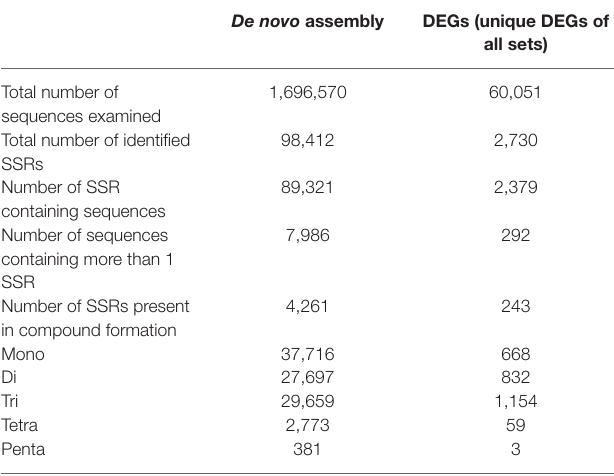
TABLE 3 | Details of SSR markers obtained from de novo transcriptome assembly as well as unique differential expressed genes of all the stages. De novo assembly DEGs (unique DEGs of all